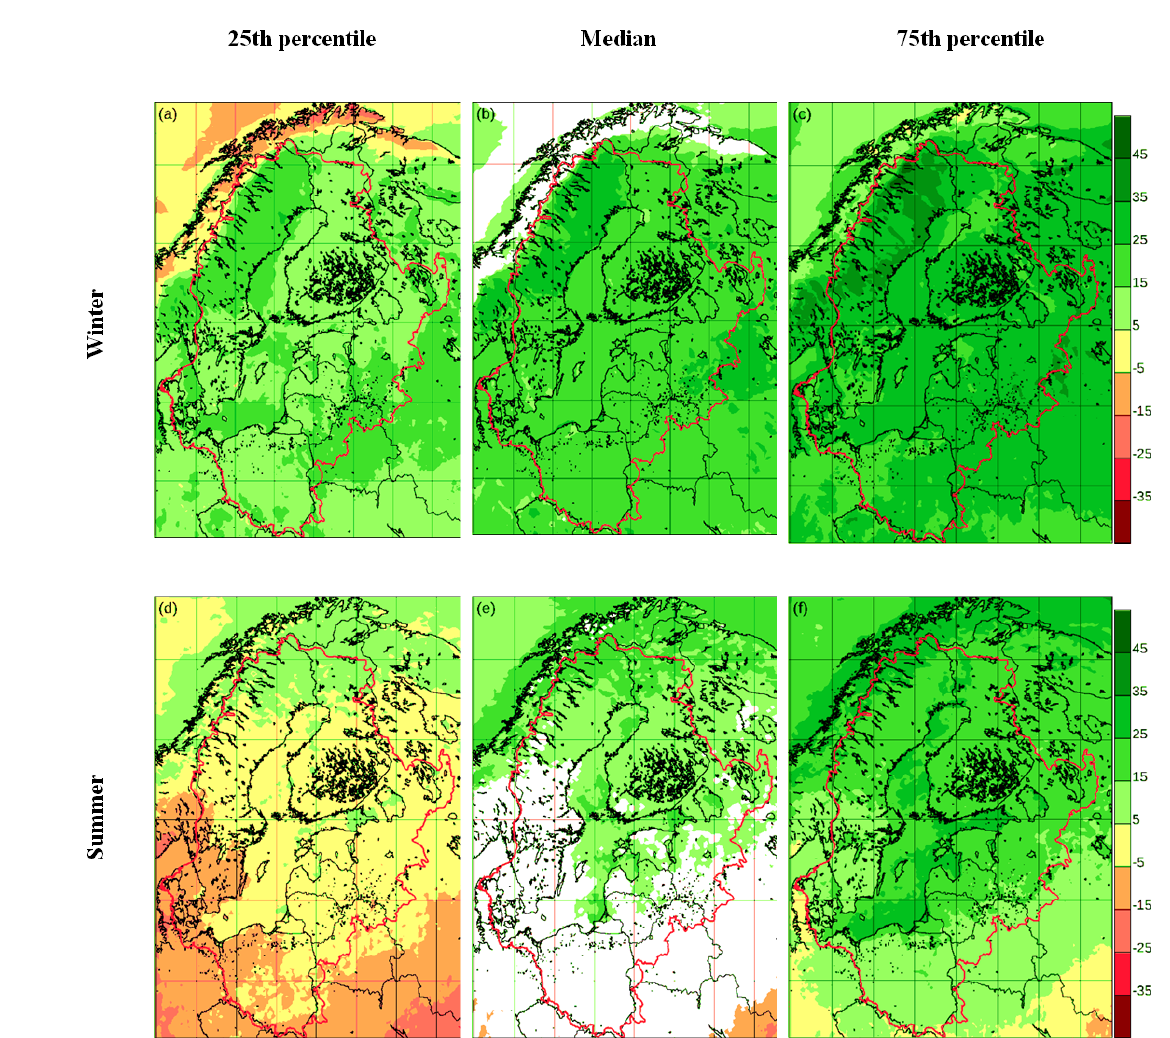
Figure 2. Precipitation relative change (%) between 1981–2010 and 2071–2100 for 72 simulations from EURO-CORDEX according to the RCP8.5 scenario. (a–c) Winter. (d–f) Summer. (a, d) Lowest quartile; (b, e) median value; (c, f) higher quartile. In all following figures, panels (b, e) depicting pointwise median values are only coloured when 75% of simulations agree on the sign of the change. The Baltic Sea catchment is indicated in